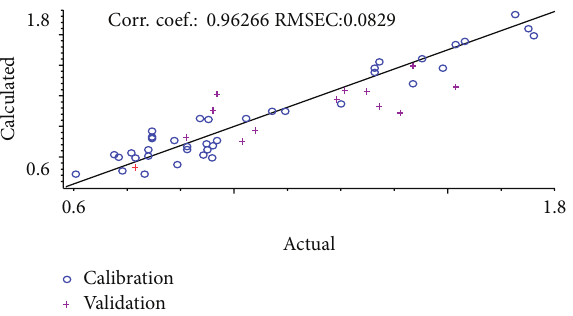
Figure 4: Correlation diagram between the NIR model calculated